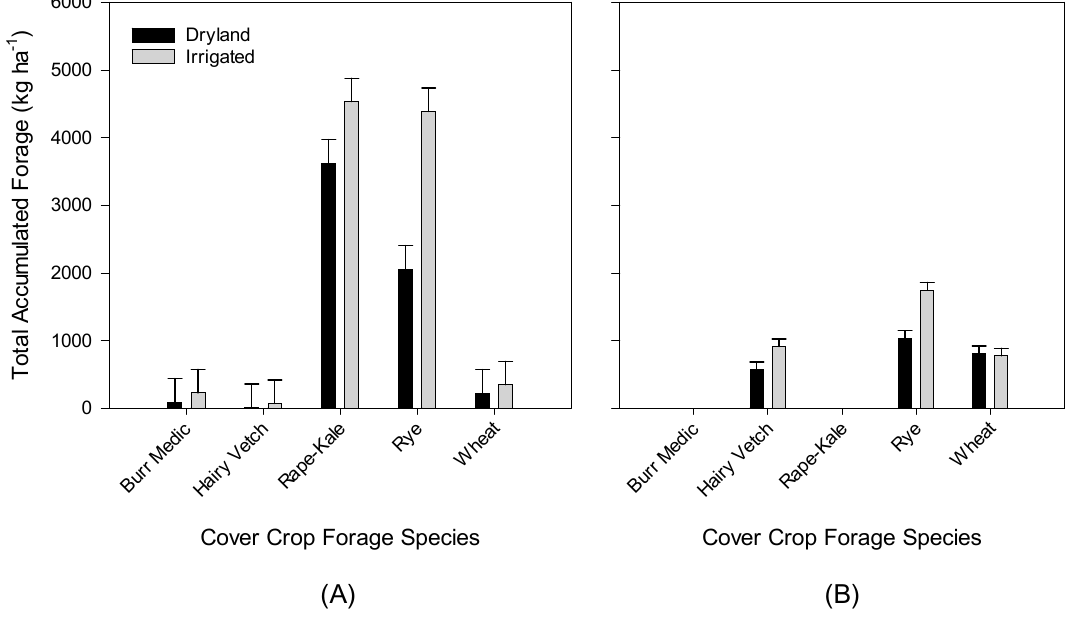
Figure 2. Total accumulated forage produced by each irrigation x cover crop forage species combination within each year. ( A ) Data were collected on 9 March, 23 March, and 22 April 2016 in Year 1 ( n = 36). ( B ) Data were collected on 6 March and 28 April 2017 in Year 2 ( n = 72). Data averaged over blocks and tillage treatment (applicable in year 2 only). Error bars represent standard error.